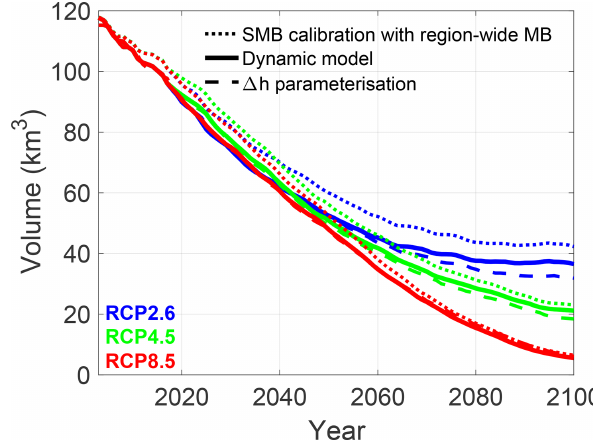
Figure 13. Future glacier volume evolution as simulated with (i) the dynamic model forced with an SMB calibrated to individ- ual glaciers (standard run), (ii) the (cid:49)h parameterisation (Huss et al., 2010b) and (iii) the dynamic model, for which the SMB model component is calibrated with a region-wide MB estimate. Results are shown for glaciers longer than 1km at inventory date and cor- respond to the multi-model values from RCM simulations from the EURO-CORDEX ensemble (for a given